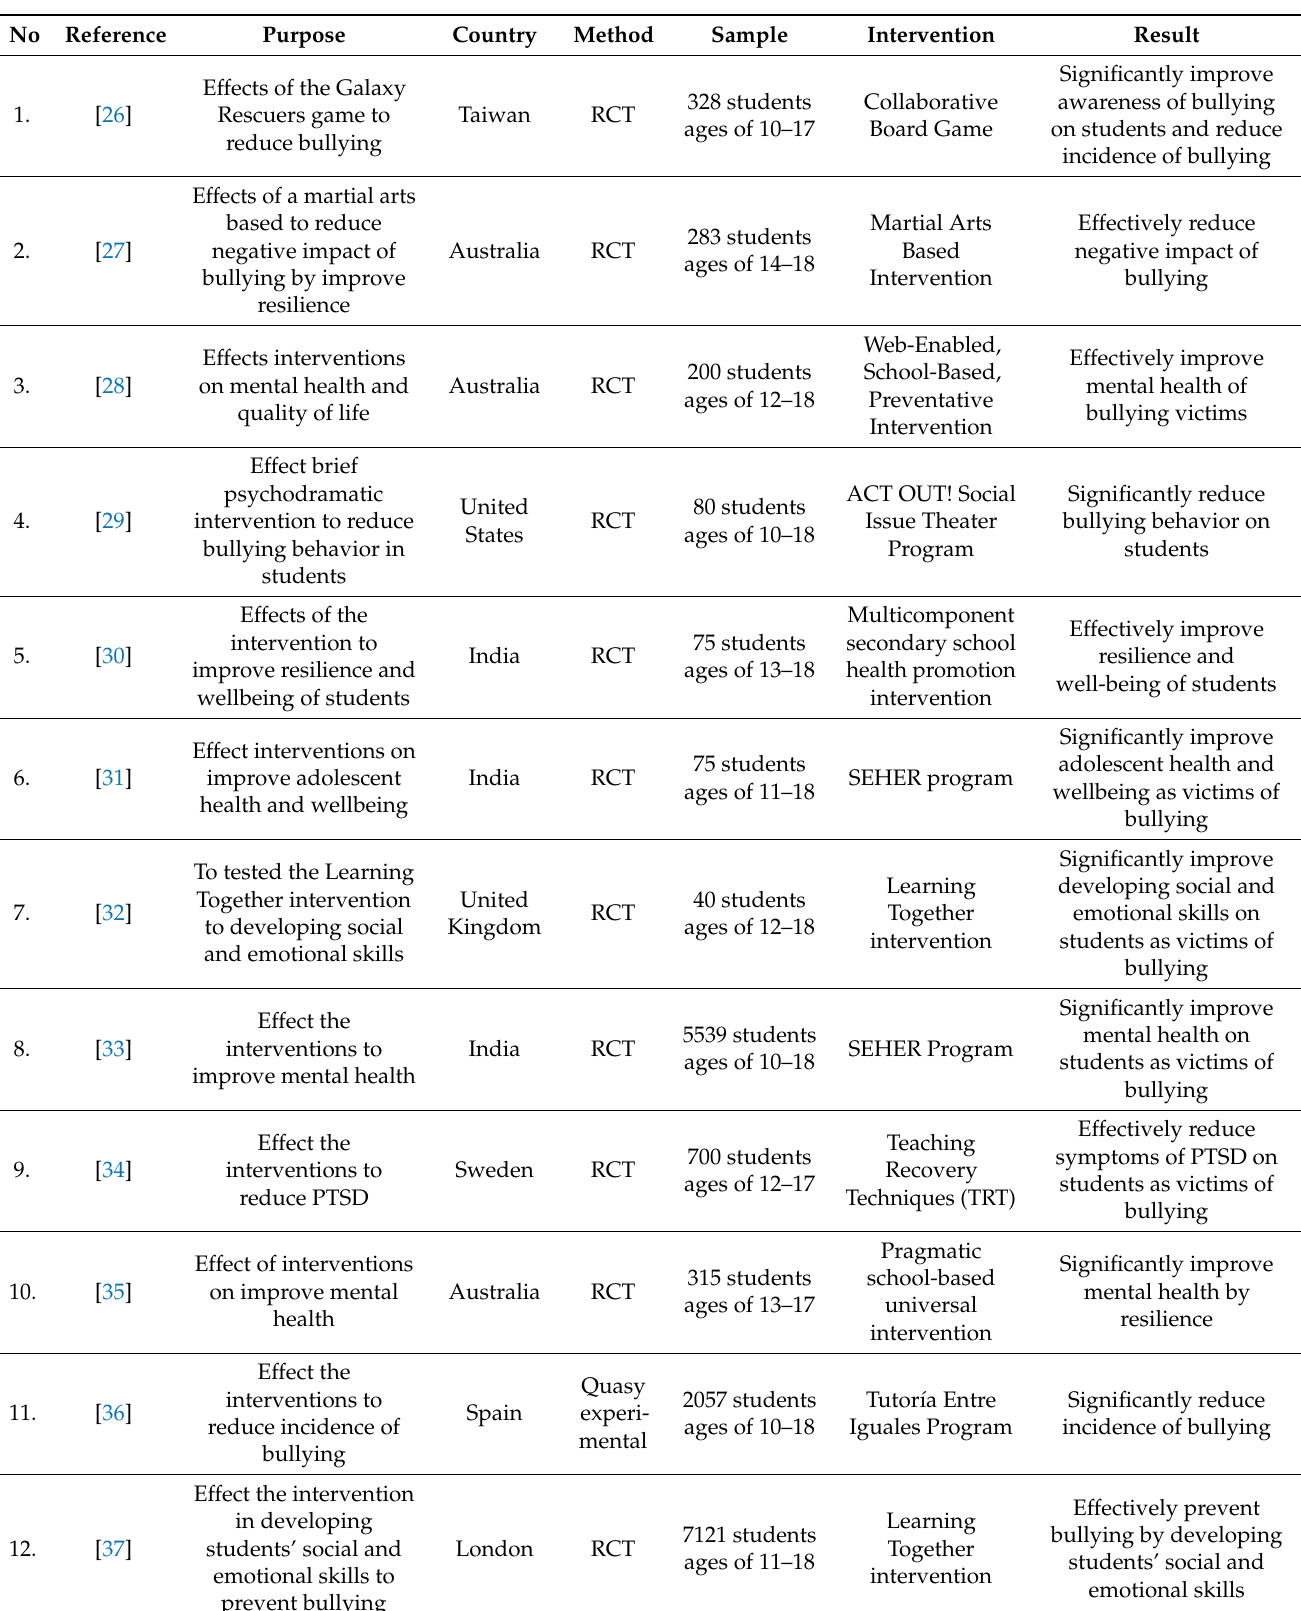
Table 2. Extraction